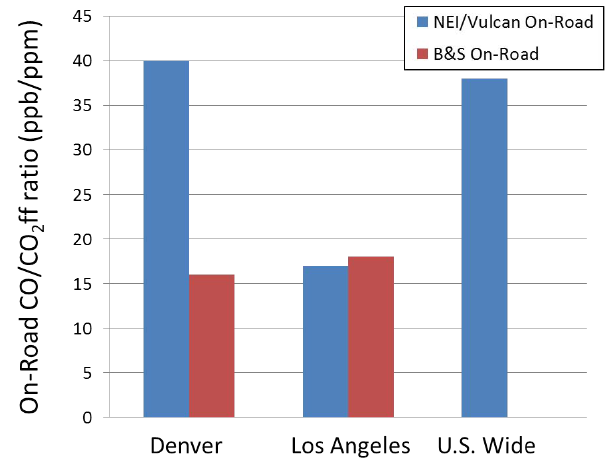
Fig. 8. On-road sector CO/CO 2 ff emission ratios derived from the tailpipe observations of Bishop and Stedman (2008) (B&S, red) and from the sector-specific NEI08 CO and Vulcan 2.2 CO 2 emissions estimates (blue) for Denver, Los Angeles, and the